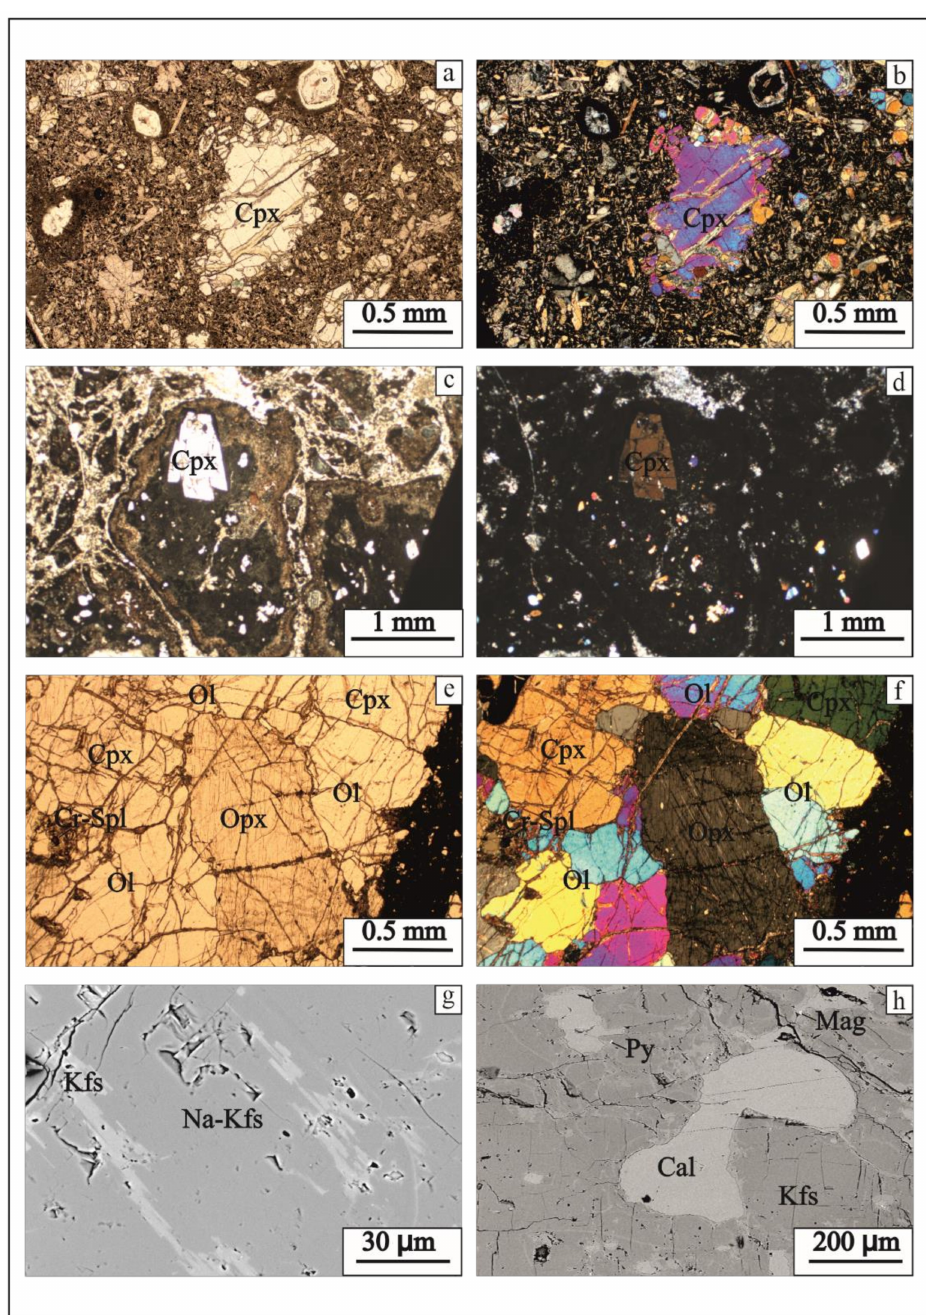
Figure 10. Image optical microscope. ( a , b ) Massive facies with ocelli. In the centre, corroded cpx phenocrysts (Augite) in plane-polarised light augite) (// and X- ( a ), which shows high birefringence colours under crossed polarised light; respectively); ( c , d ) brecciated facies shows a series of parallel and crossed polarised light showing auto-lapilli (// and X-Nicols); ( e , f ) plane and crossed polarised light images of nodules including a lherzolite nodule from the brecciated facies showing granular clinopyroxene, olivine, orthopyroxene with clinopyroxene exsolution lamellae exsolutions, and accessory Cr–spinel and amphibole. BSE Images. ( g ) Calcite–syenite xenolith showing K-feldspar ex- solution perthites in Na-feldspar (BSE image); ( h ) calcite–syenite showing intergranular phenocrysts primary calcite, pyrite, and magnetite inclusion in K-feldspar. Symbols: Cpx—clinopyroxene; Ol— olivine; Opx—ortopyroxene; Kfs—k-feldspar; Py—pyrite; Mag—magnetite;